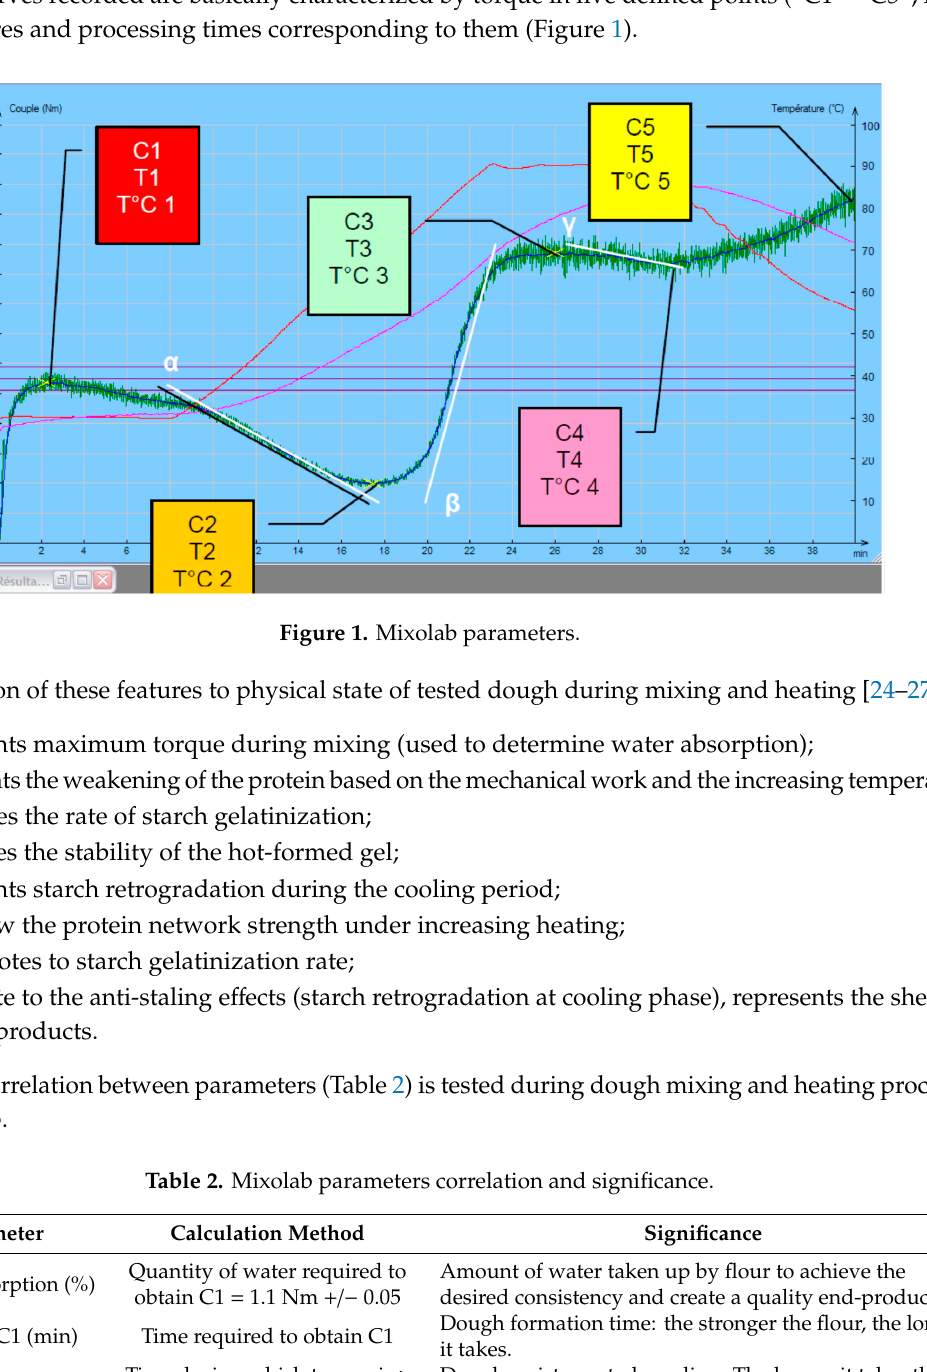
Table 2. Mixolab parameters correlation and significance